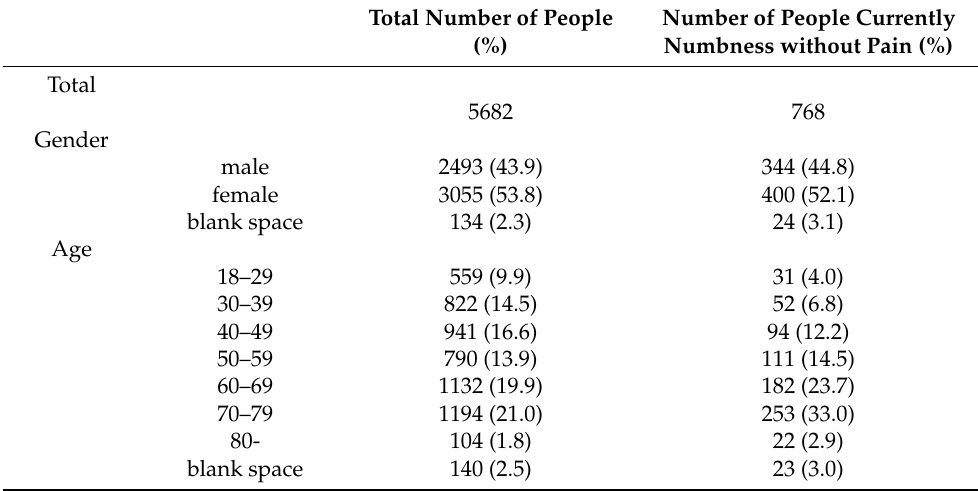
Table 1. Background information on the 5682 people who responded to the survey and the 768 people who are currently experiencing numbness without pain.